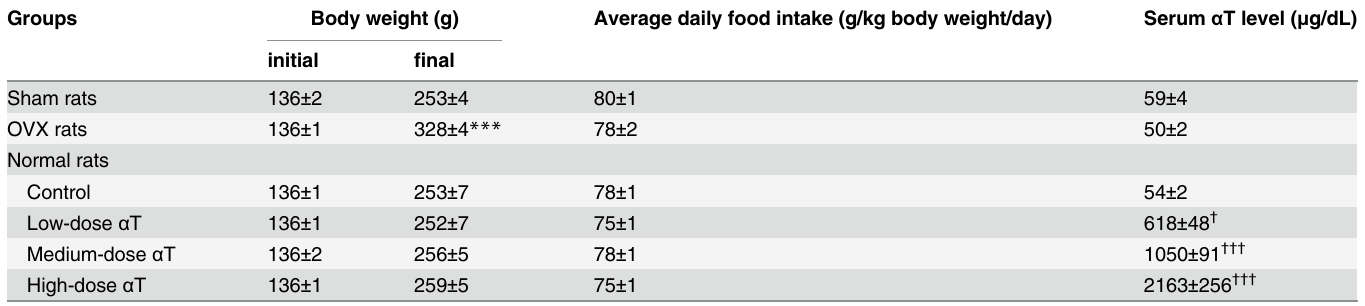
Table 2. Effects of α T supplementation on body weight, food intake, and serum α T levels.